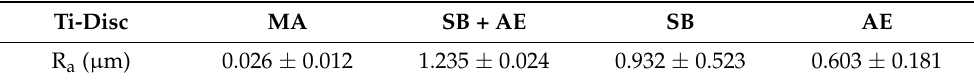
Table 1. Mean ± standard deviation of the surface roughness parameter Ra for the different types of Ti implants. Ti-Disc